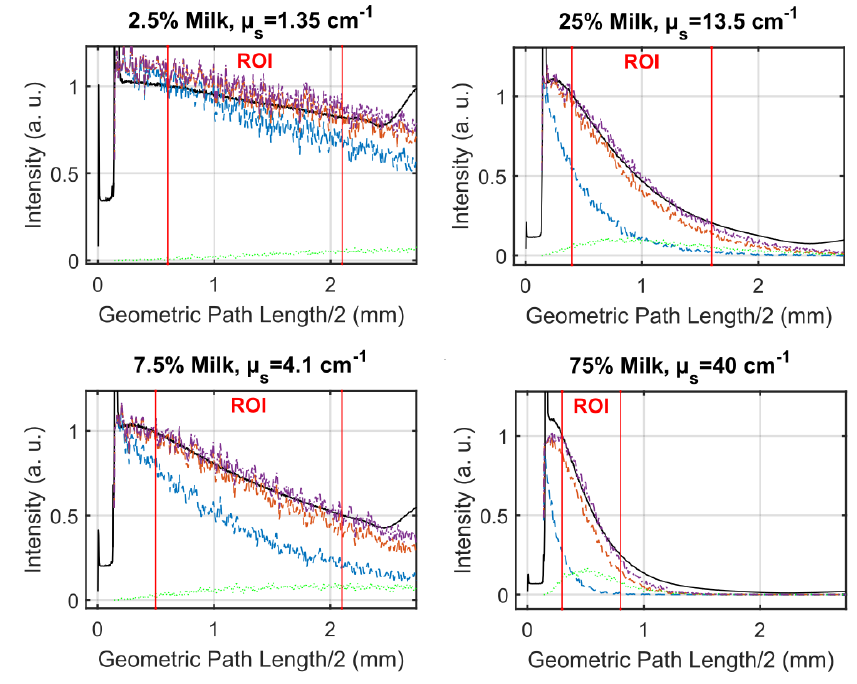
Figure 29. Contribution of different photon categories to the simulated OCT signal (purple) for different µ lin s : MSP (green), LSP (red), ballistic (blue). The deconvolved OCT signal is shown in black and the region of interest (ROI) for calculation of the scattering coefficient of the sample assuming a pure exponential decay is marked by red vertical lines (reproduced with permission from